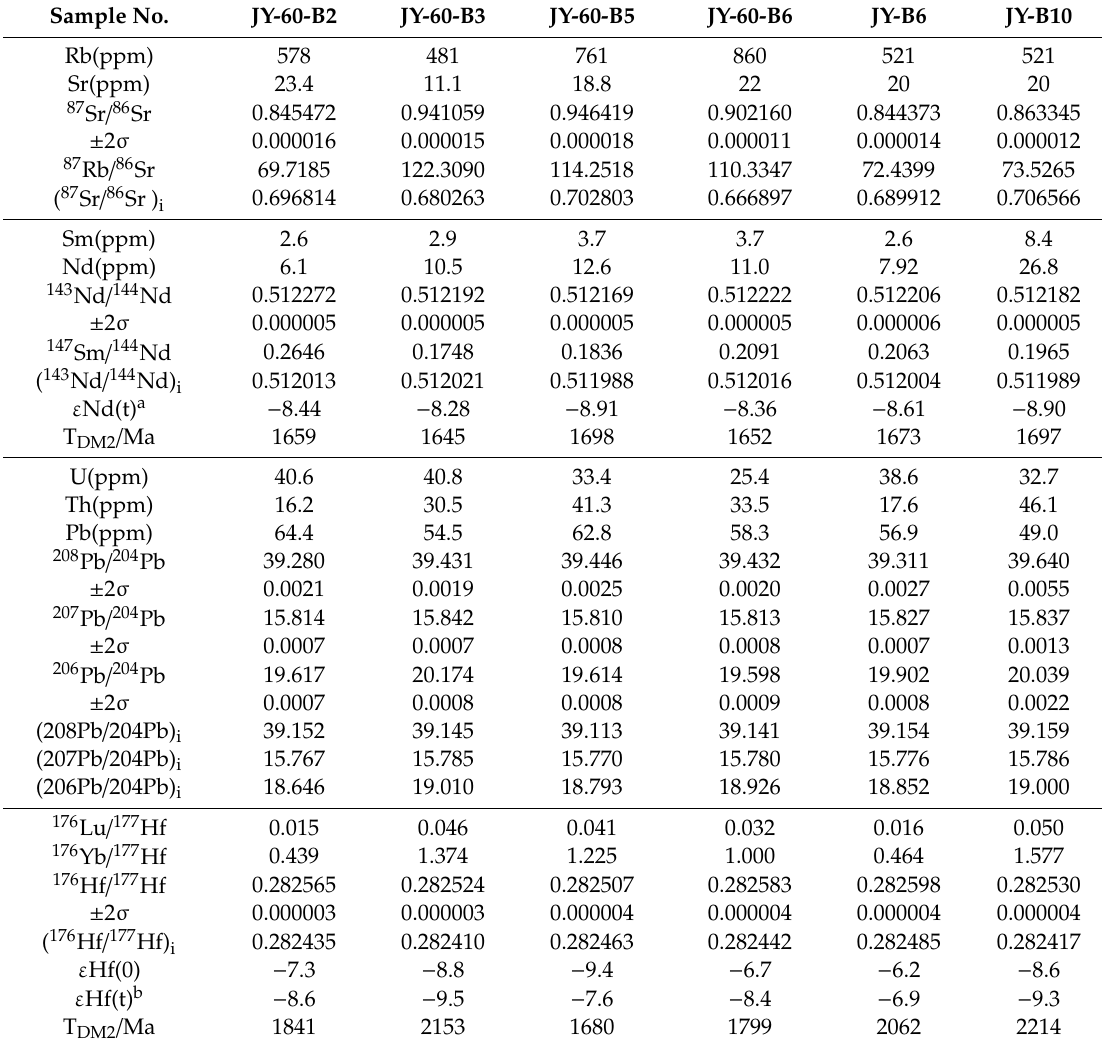
Table 2. Bulk rock Sr-Nd-Pb-Hf analyses for Junye